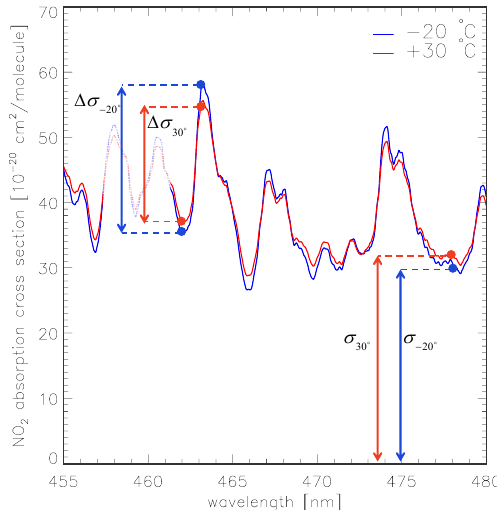
Fig. 4. NO 2 cross section spectrum σ at two different tempera- tures (Vandaele et al., 1998). The figure illustrates that a change in effective NO 2 temperature (see Sect. 3.2.2) leads to a relative change in the differential cross section ( 1σ ), used in the DOAS fit- ting, that is larger than the relative change of the cross section itself. A correction based on the temperature dependency of 1σ is ap- plied to the measured differential slant NO 2 columns, since they are derived from a DOAS fit performed with an NO 2 cross section of 295K. A correction of simulated measurements (that are calculated in the look-up table for only two values of the surface temperature (Sect. 3.2.1)) is based on the temperature dependency of σ